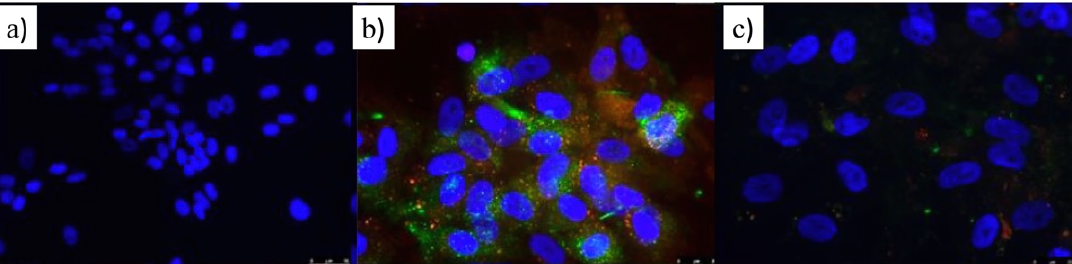
Figure 6. Fluorescent microscopy images denoting the expression of ICAM (green) and VCAM (orange–red) in ( a ) non-activated and ( b ) LPS-activated HUVEC cells, and ( c ) LPS-activated HUVECs after treatment with 5 × 10 10 NPs/mL of ATOR-PLGA/miRNA NPs (20 mM drug–100 nM miRNA). In blue, DAPI channel; in red, labeled VCAM Ab; in green, labeled ICAM Ab. Scale is 25 mm.